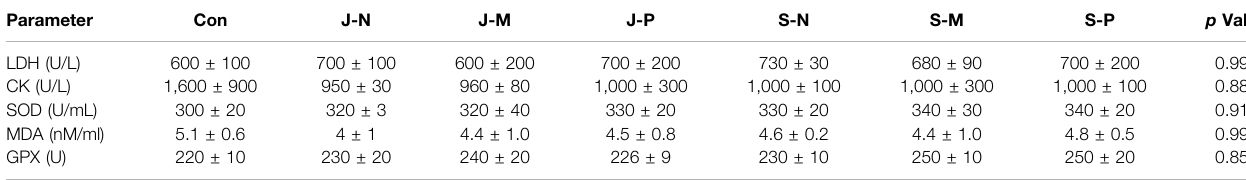
TABLE 5 | Myocardial enzyme and antioxidant index after different PAL treatments. Parameter